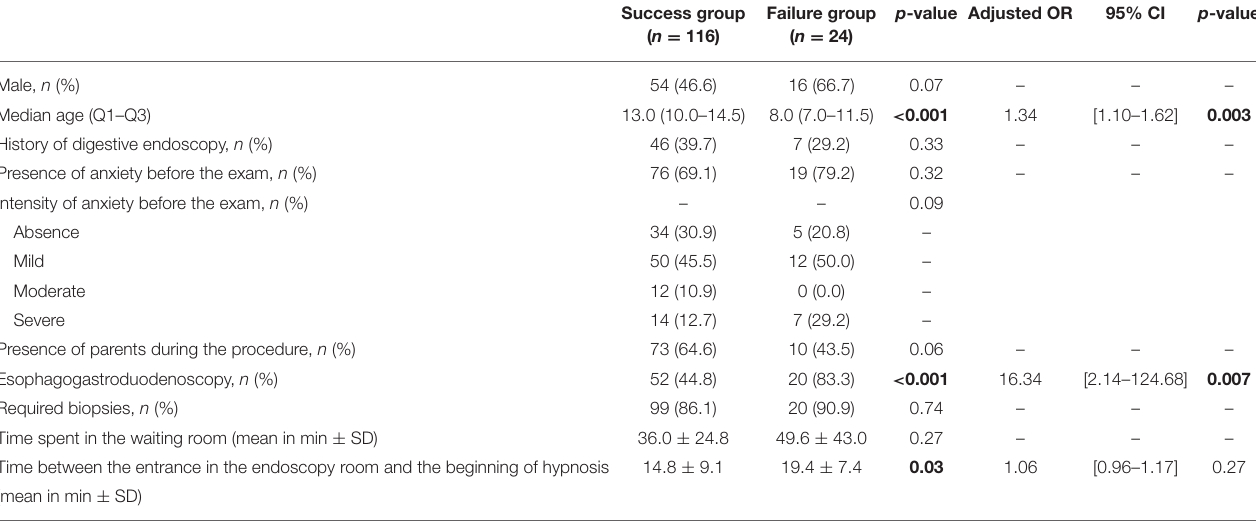
TABLE 3 | Predictive factors of successful gastrointestinal